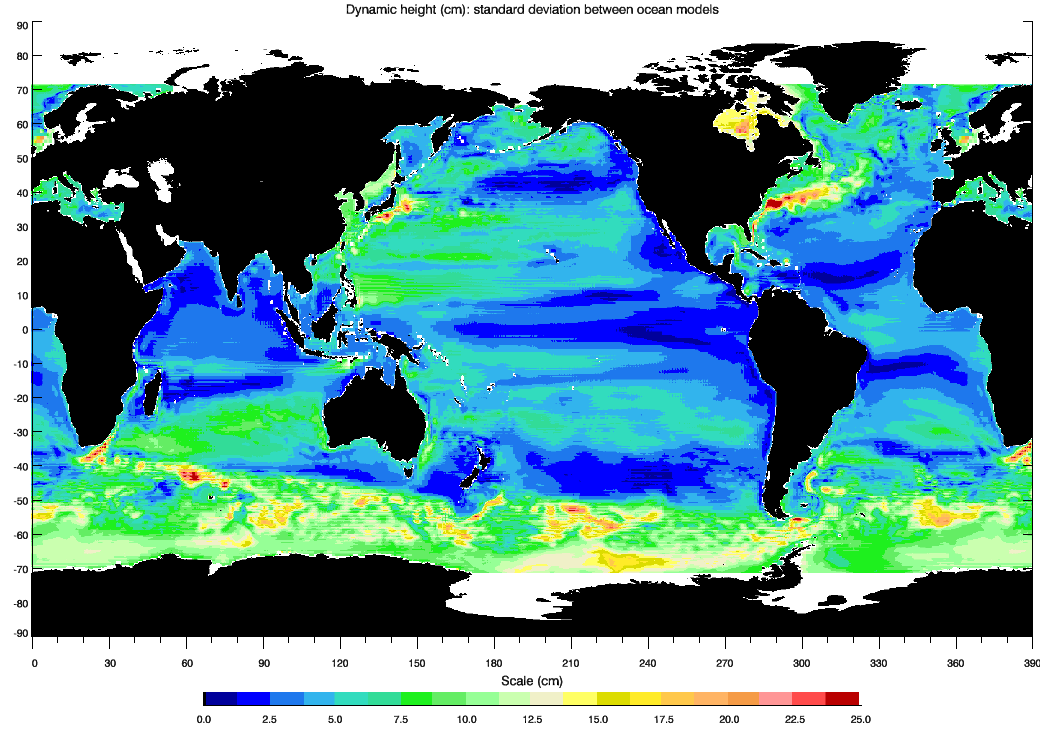
Figure 7. Standard deviations at each point in the ocean between the MDT values for a set of ocean models described in the text.